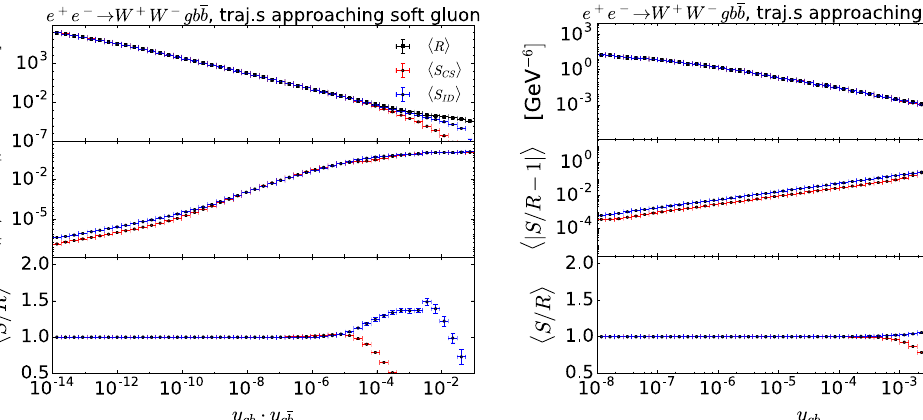
same trajectory like described in the text. Right: Average over trajec- tories in phase-space with increasingly soft gluon, left: Average over trajectories with increasingly collinear qg-pair